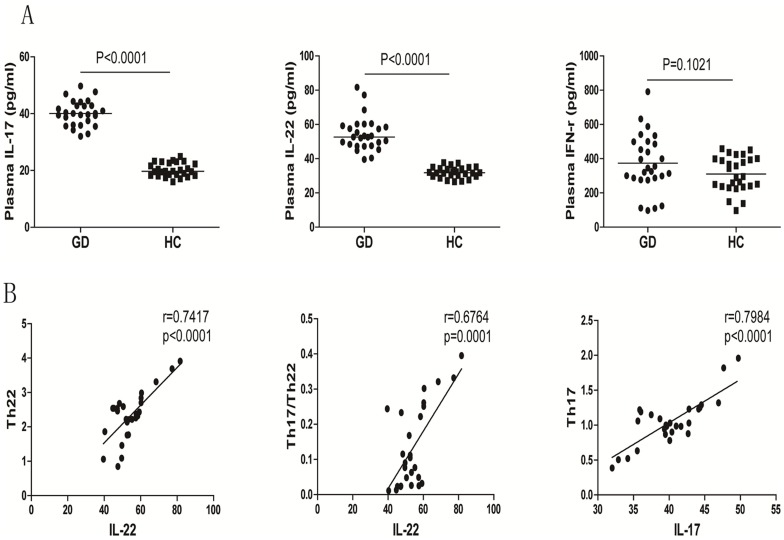
The concentrations of plasma cytokines in the subjects.The concentrations of plasma IL-17, IL-22, and IFNγ in individual subjects were measured by ELISA and the potential association of the concentrations of plasma cytokines with the percentages of corresponding cells was analyzed by Spearman rank correlation test. Data are expressed as the mean values of individual subjects (n = 27 for each group) from five separate experiments. A. ELISA analysis of the levels of plasma cytokines; B. Correlation analysis. The concentrations of plasma IL-17 were not correlated significantly with the percentages of Th17/Th22 cells in those patients (data not shown).